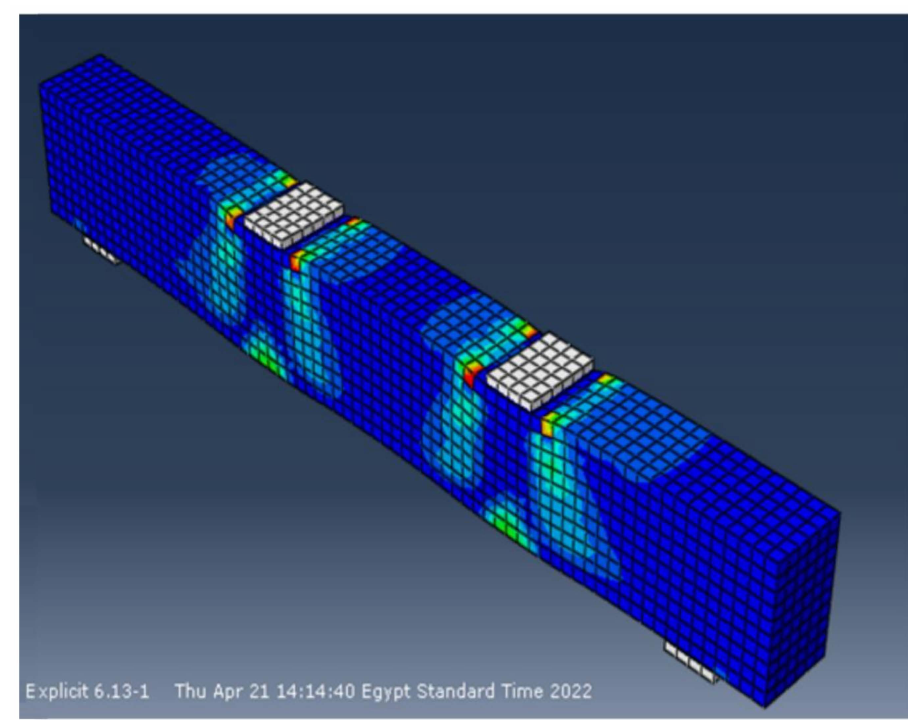
Figure 14. Final crack pattern of specimen